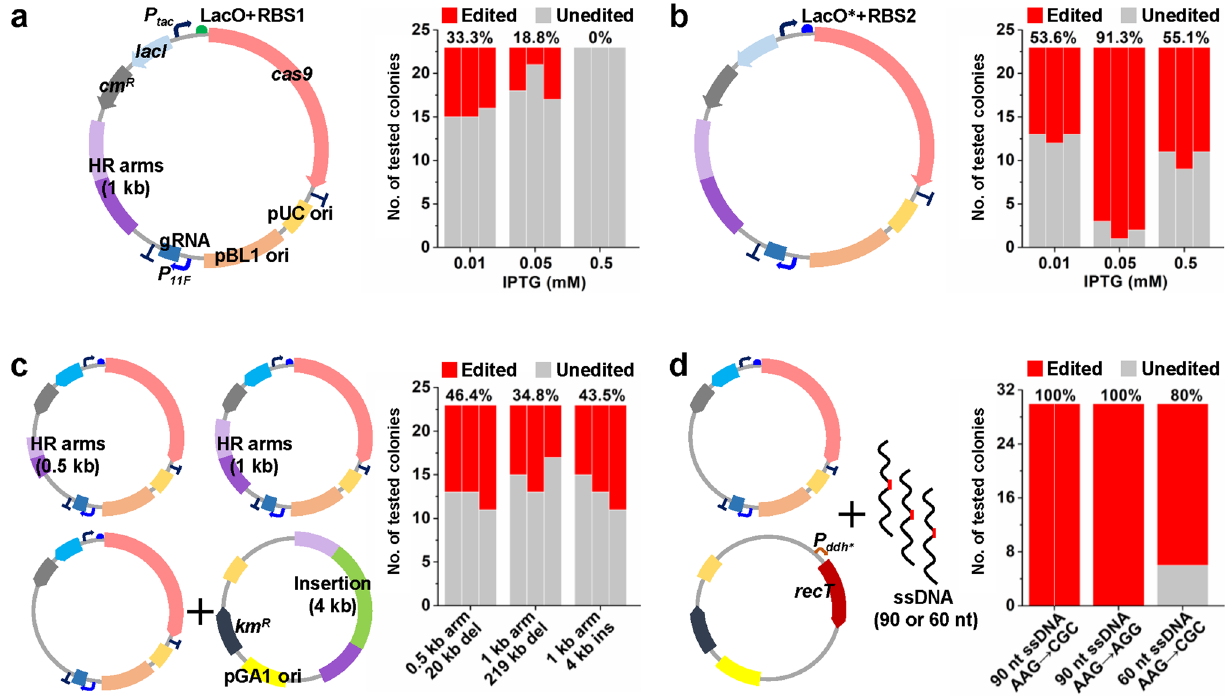
Fig. 1 Gene deletion, insertion, and ssDNA recombineering in C. glutamicum using the optimized CRISPR/Cas9 system. a Deletion of a 1.7 kb DNA fragment ( cgl0620 - cgl0622 ) using the all-in-one plasmid. Different concentrations of IPTG (0.01, 0.05, and 0.5 mM) were used for counter-selection. b Deletion of the same 1.7 kb DNA fragment ( cgl0620 - cgl0622 ) using the optimized all-in-one plasmid with a modi fi ed lac operator that binds LacI very tightly (LacO * ) and a weak RBS (RBS2). Different concentrations of IPTG (0.01, 0.05, and 0.5 mM) were used for counter-selection. c Deletion and insertion of large DNA fragments. Three tests, deletion of a 20 kb DNA fragment (part of prophage CGP3) with 0.5 kb HR arms, deletion of a 219 kb DNA fragment (complete prophage CGP3) with 1.0 kb HR arms, and insertion of a 4 kb DNA fragment (an arti fi cial proBAC operon inserted to putA ) with 1.0 kb HR arms were conducted. For gene insertion, the inserted DNA fragment and HR arms were provided using a second plasmid. IPTG (0.05 mM) was used for counter-selection. For a , b , and c , twenty-three colonies were randomly selected and veri fi ed by PCR for each test. Results of three independent replicates are shown. Red and grey fractions of bars represent edited and unedited colonies, respectively. The average editing ef fi ciency (%) from three independent replicates is shown above the bars. d Introduction of triple and single nucleotide changes using CRISPR/Cas9-assisted ssDNA recombineering. Three tests, triple nucleotide changes with 90 nt ssDNA (two independent replicates), single nucleotide change with 90 nt ssDNA, and triple nucleotide changes with 60 nt ssDNA, were conducted to introduce rpsL K43R mutation that produced streptomycin resistance phenotype. IPTG (0.05 mM) was used for counter-selection. Thirty colonies were randomly selected and veri fi ed by streptomycin resistance phenotype test. Red and grey fractions of bars represent edited and unedited colonies, respectively. The editing ef fi ciency (%) is shown above the bars. Genetic elements on the plasmids: P tac , IPTG-inducible tac promoter; P 11F , 11F constitutive promoter 32 ; P ddh * , a variant of the promoter of ddh gene (Supplementary Data 6); LacO, wild-type lac operator; LacO * , a modi fi ed lac operator that binds LacI tightly 42 ; RBS1, a strong RBS AAAGGAGTTGAGA; RBS2, a weak RBS AAAGGCACCCGAT; pUC ori, pUC origin of replication; pBL1 ori, pBL1 origin of replication; pGA1 ori, pGA1 origin of replication; cas9 , S. pyogenes Cas9 gene; gRNA, guide RNA expression cassette; HR arms, homologous recombination arms; cm R , chloramphenicol resistance gene; km R , kanamycin resistance gene; recT , gene encoding the recombinase from the Rac prophage of E. coli ; Insertion, the 4 kb DNA fragment for insertion test. Images for DNA gel electrophoresis and streptomycin resistance phenotype test are provided in Supplementary Figs. 1 and 3. Source data underlying Fig. 1 are provided as a Source Data fi